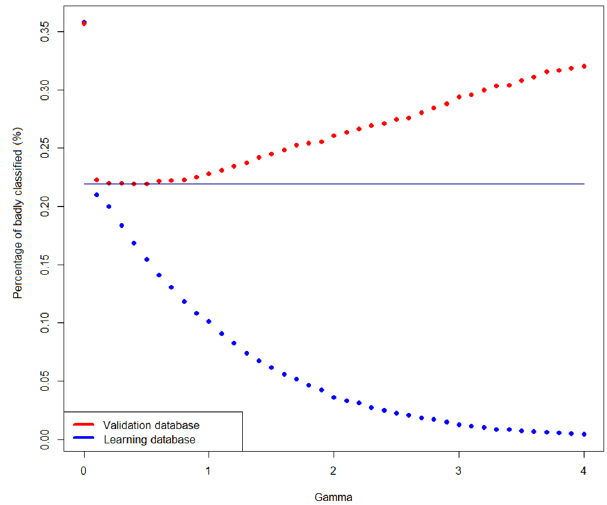
Figure 10. Error rates according to the parameter γ for a radial nodal.